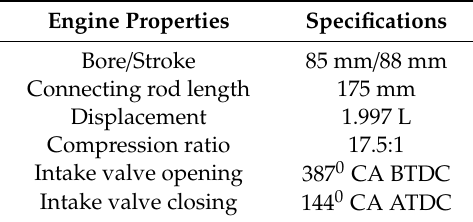
Table 1. Specifications of the test